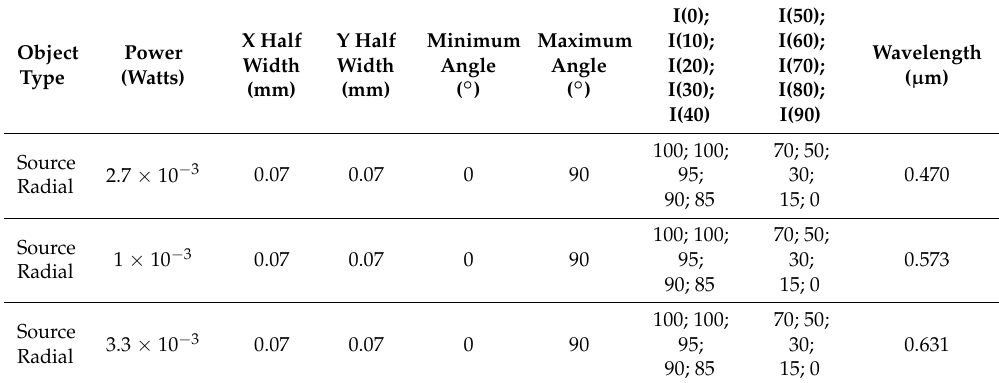
Table 2. LEDs data in non-sequential mode, using the ZEMAX ® optical